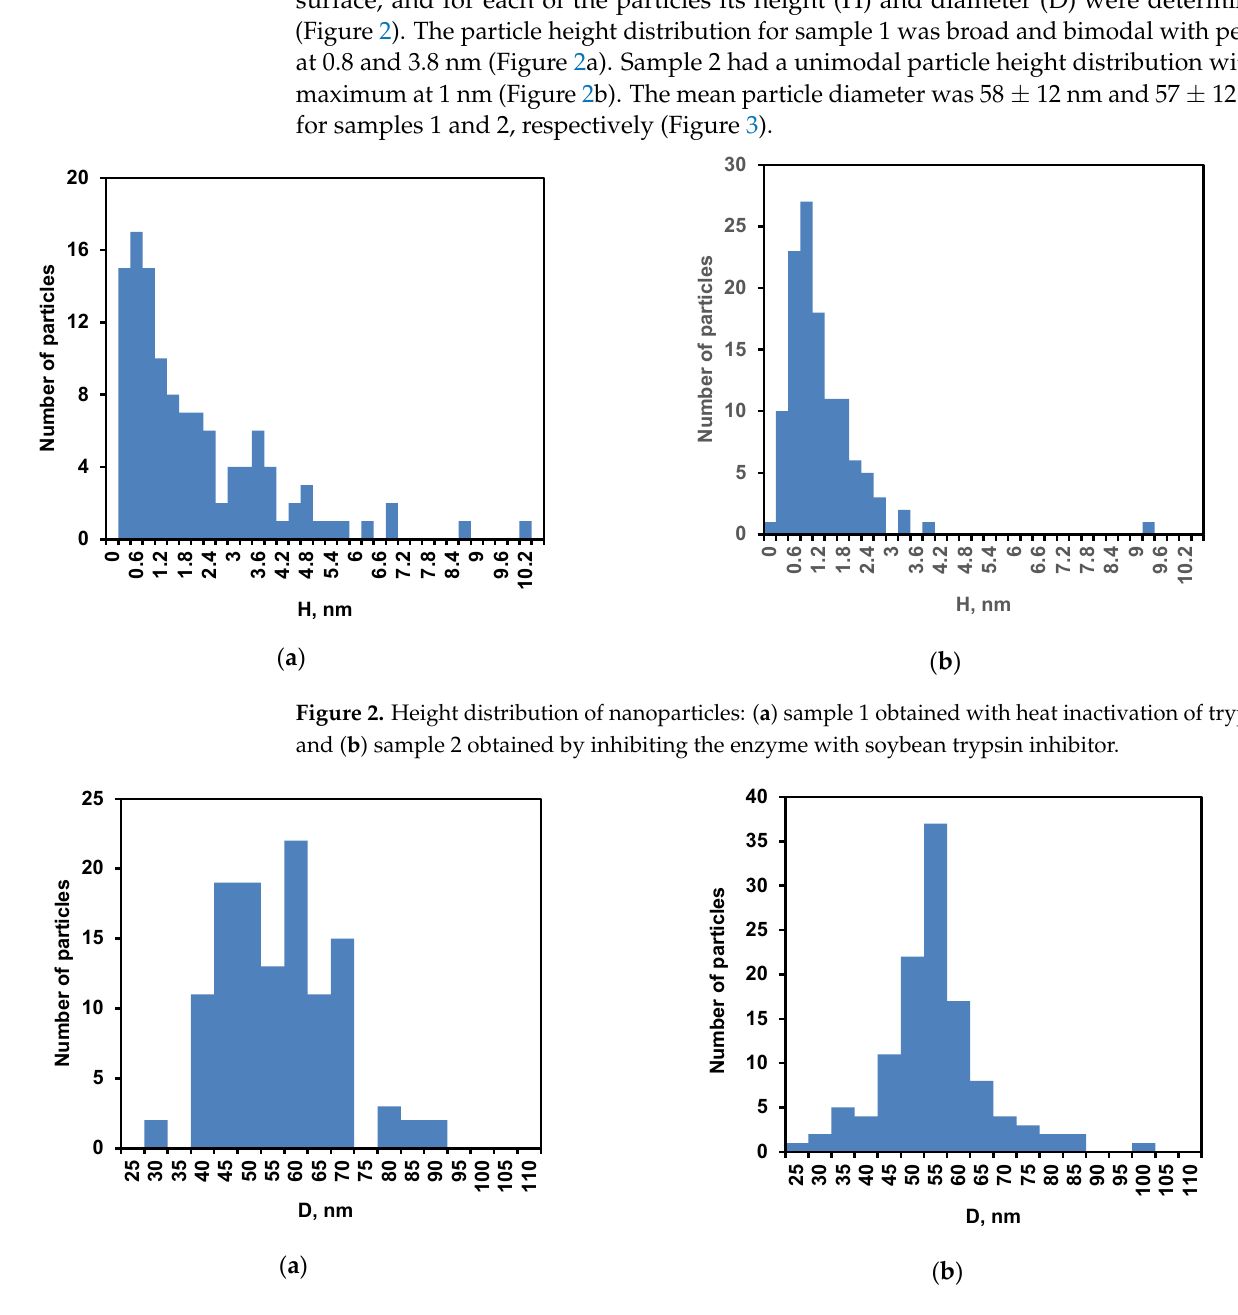
Figure 3. Diameter distribution of nanoparticles: ( a ) sample 1 obtained with heat inactivation of trypsin and ( b ) sample 2 obtained by inhibiting the enzyme with soybean trypsin inhibitor.